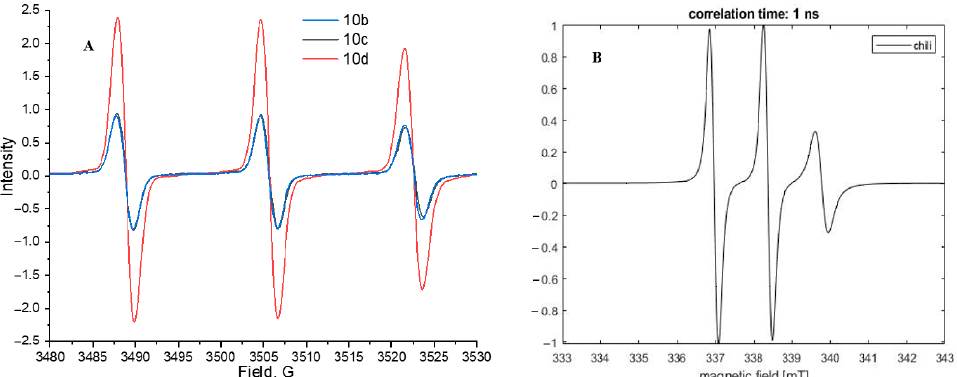
Figure 1. ( A )-EPR spectra of lanthanide (III) complexes 10b–d in deionized water at r.t. ( B )-predicted spectrum of the nitroxide radical.